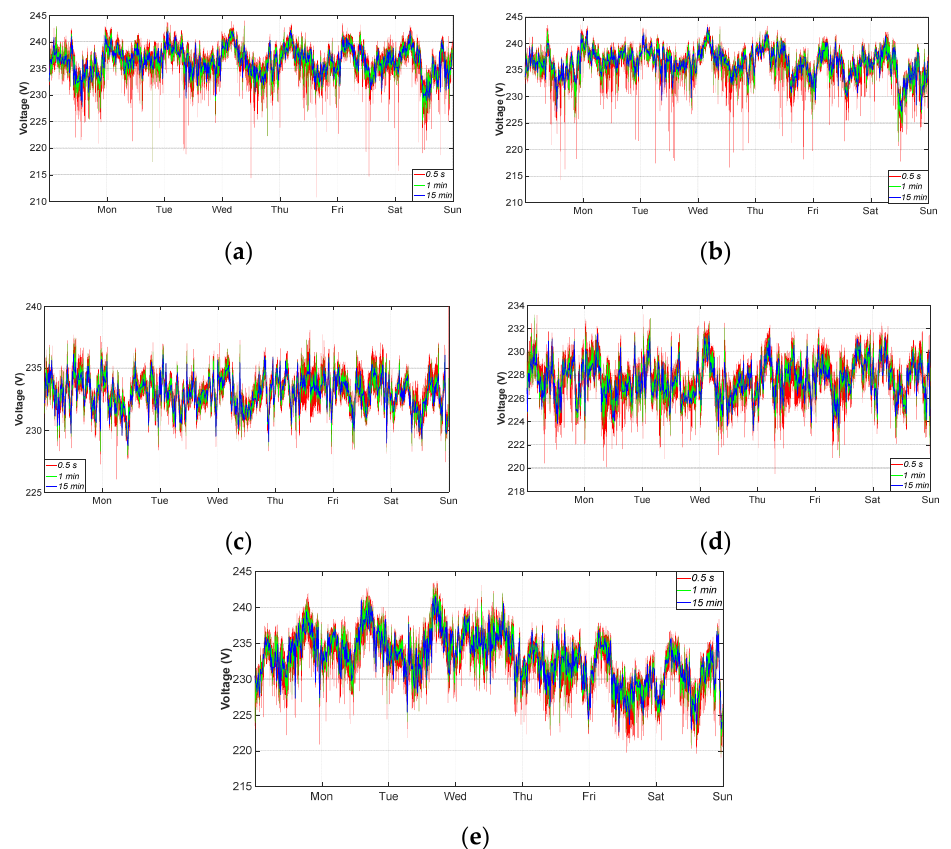
Figure 11. Weekly voltage distribution: ( a ) Household #1, ( b ) Household #2, ( c ) Household #3, ( d ) Household #4 and ( e ) Household #5.